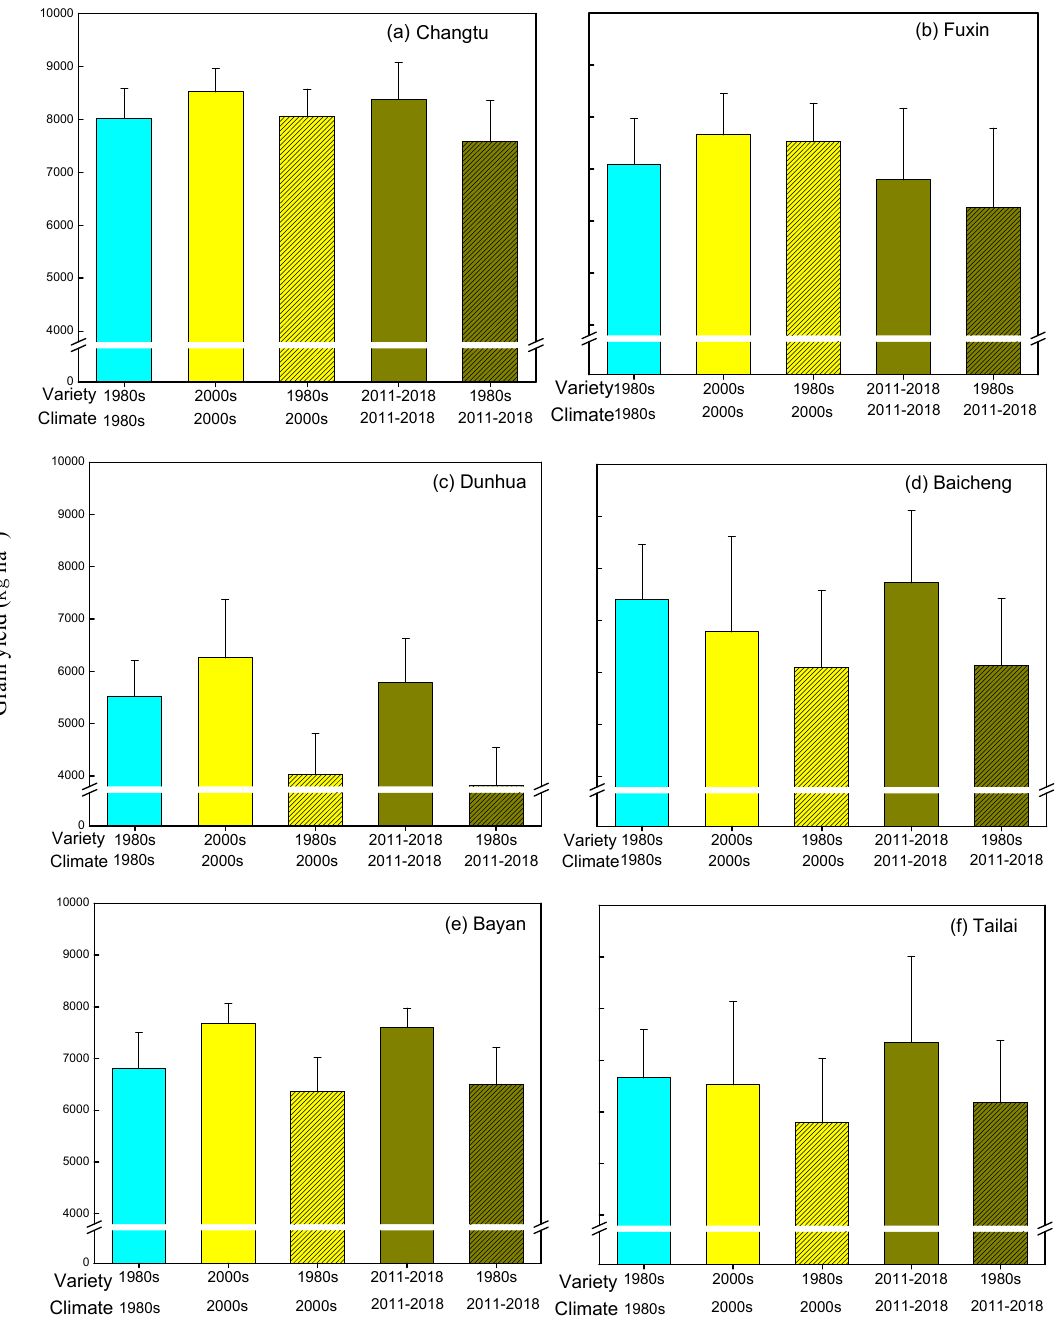
Figure 4. Simulated combined effects of variety (varieties planted in the 1980s and 2000–2018) and climate (climate in the 1980s and 2000–2018) on grain yields in humid region ( a , c , e ) and semi-humid region ( b , d , f ) stations. Error bars indicate standard deviations.